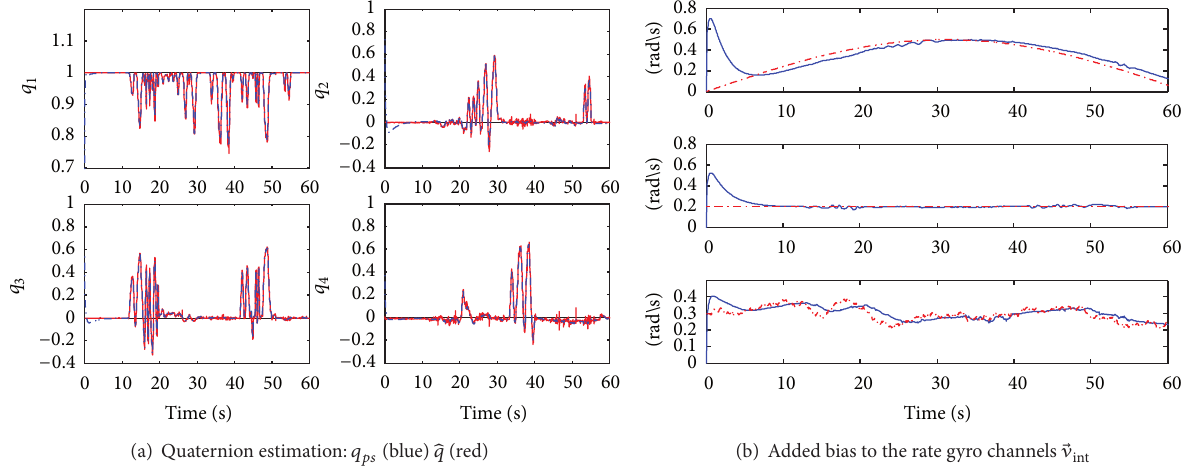
Figure 9: Estimation of the quaternion and the gyro bias.